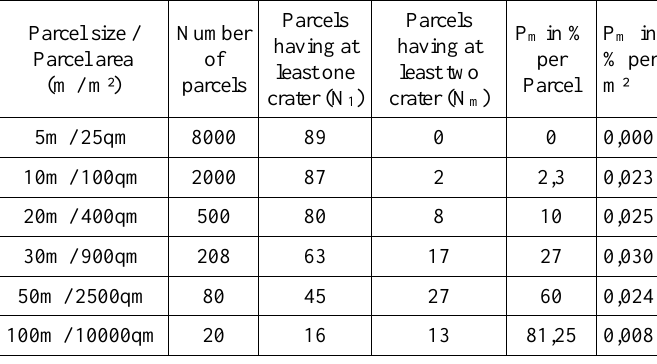
Figure 2. a bombarded area overlaid by a 5 meter raster. No